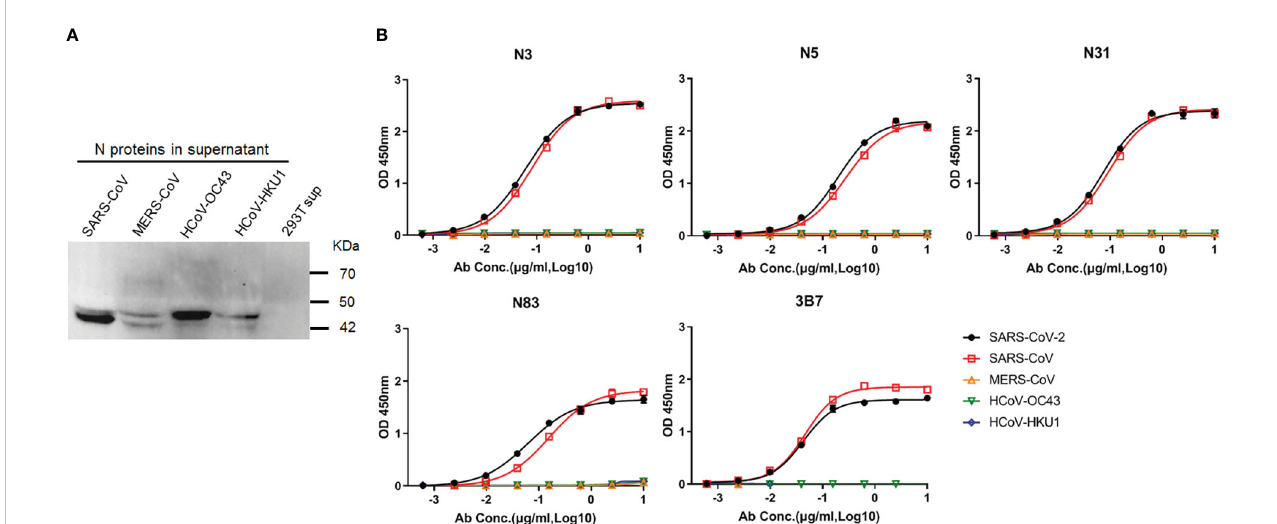
FIGURE 3 Patient – derived mAbs cross – reacted with the N proteins of human b – CoVs. (A) Western blot showing N proteins in the supernatant of 293 T cells that were transfected with recombinant pcDNA3.1 constructs to express N protein of SARS – CoV, MERS – CoV, OC43, or HKU1. Supernatant of 293 T cells